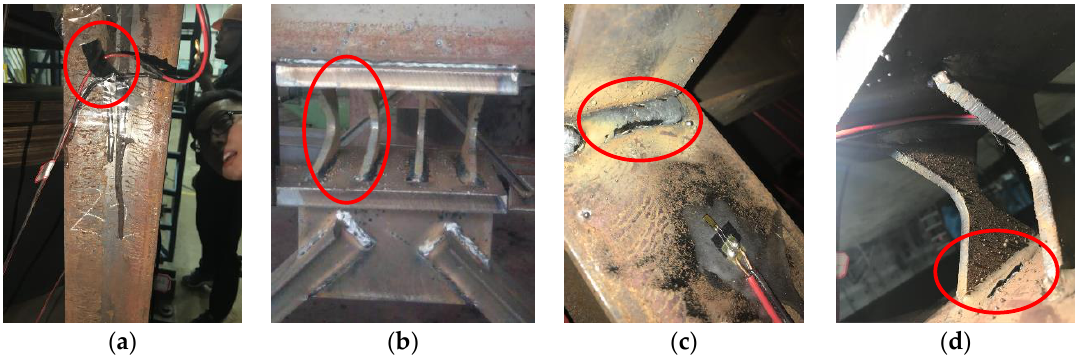
Figure 16. Test phenomena of the specimen. ( a ) Fallen wire; ( b ) deflection of energy absorbers; ( c ) fracture of the weld at the beam–column joint; ( d ) fracture of the weld at the LYP plate.